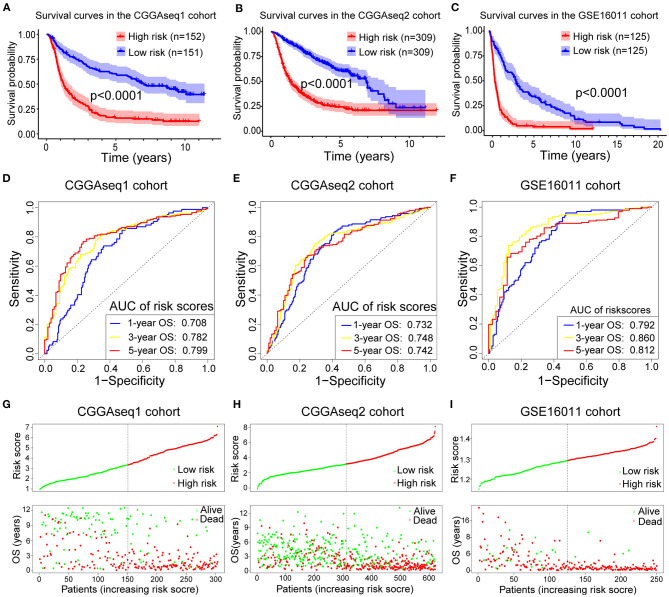
(A–C) Survival curves showing how the RBP-signature stratifies glioma patients into two subgroups with significantly distinct clinical outcomes in the three validation cohorts. (D–F) Receiver operating characteristic (ROC) curves showing the 1-, 3-, and 5-year OS predictive efficiency of the RBP-signature in the three validation cohorts. (G–I) Patient distribution plots showing patients with higher risk scores are associated with shorter OS in the three validation cohorts.